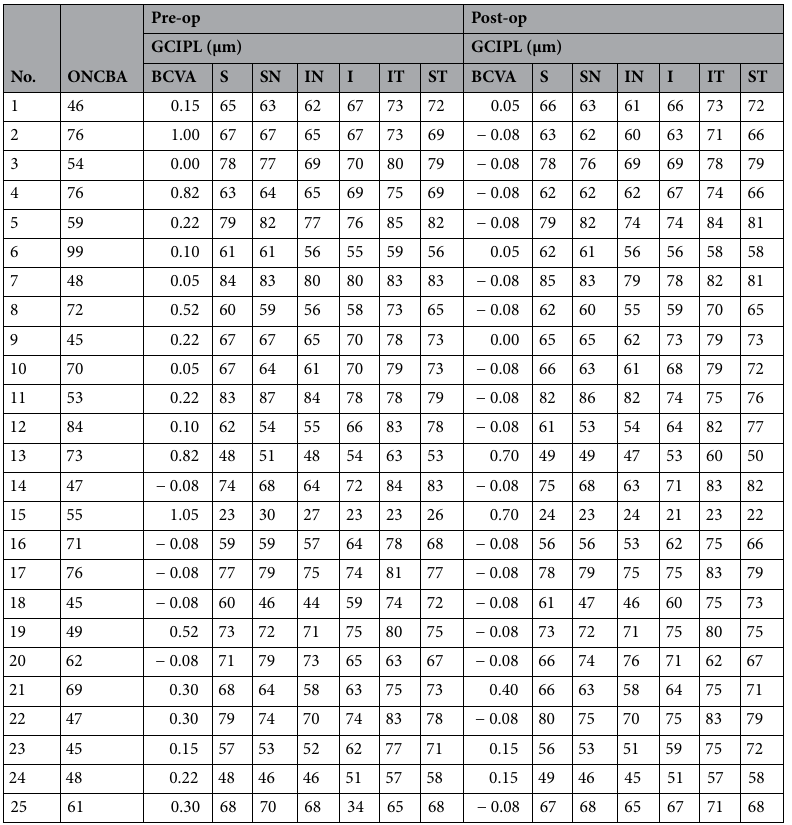
Table 2. Angle of bending and ophthalmologic parameters of patients with optic nerve bending. ONCBA optic nerve–canal bending angle, BCVA best-corrected visual